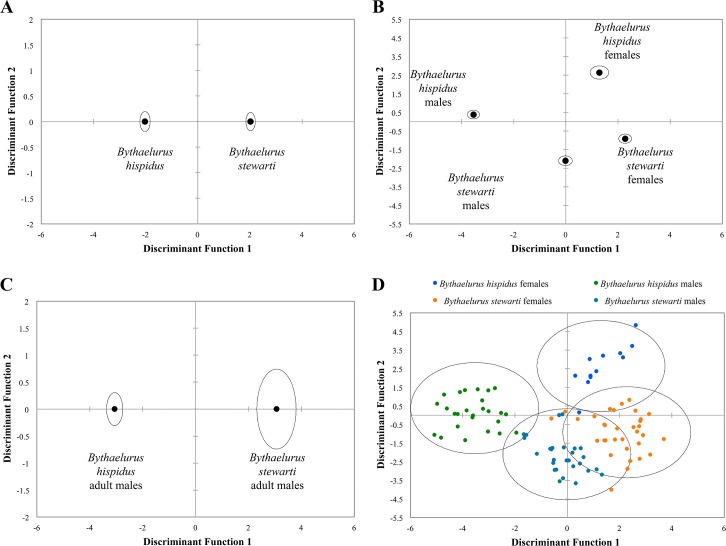
Plots of group centroids of Bythaelurus stewarti n. sp. and B. hispidus.(A) all analyzed specimens of B. stewarti n. sp. and B. hispidus, (B) males and females of B. stewarti n. sp. and B. hispidus, (C) adult males of B. stewarti n. sp. and B. hispidus. Circles represent 95% confidence intervals for group centroids. (D) Plot of all analyzed male and female specimens of B. stewarti n. sp. and B. hispidus. Circles include 95% of specimens in each group.